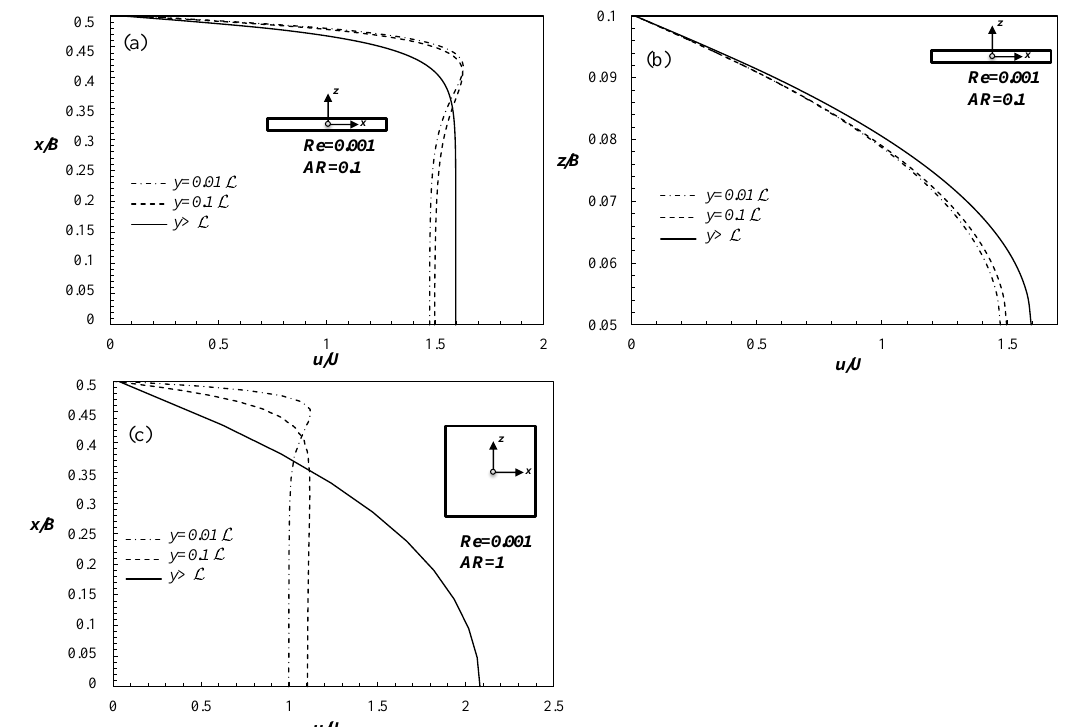
Figure 3. Velocity profiles obtained for AR = 0.1 ( a ) and AR = 1 ( c ) in the x − plane, for Re = 0.001 at different y positions along the microchannel ( z = 0). ( b ) Velocity profiles obtained for AR = 0.1 and Re = 0.001 in the z − plane, for different y positions along the microchannel ( x = 0). Re=100 AR=0.1